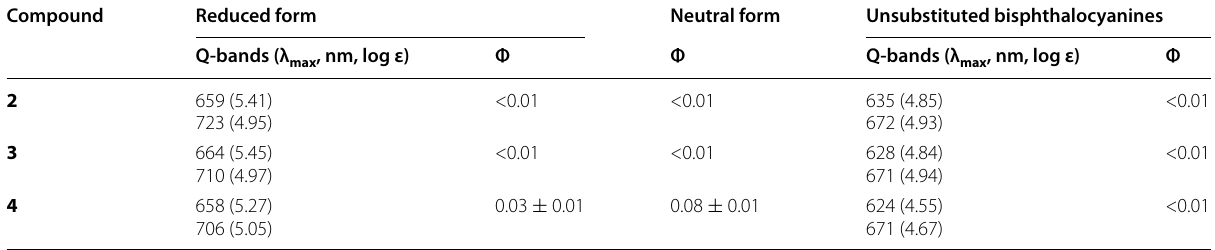
Table 1 Spectral and photochemical data for phthalocyanines 2–4 in DMF Compound